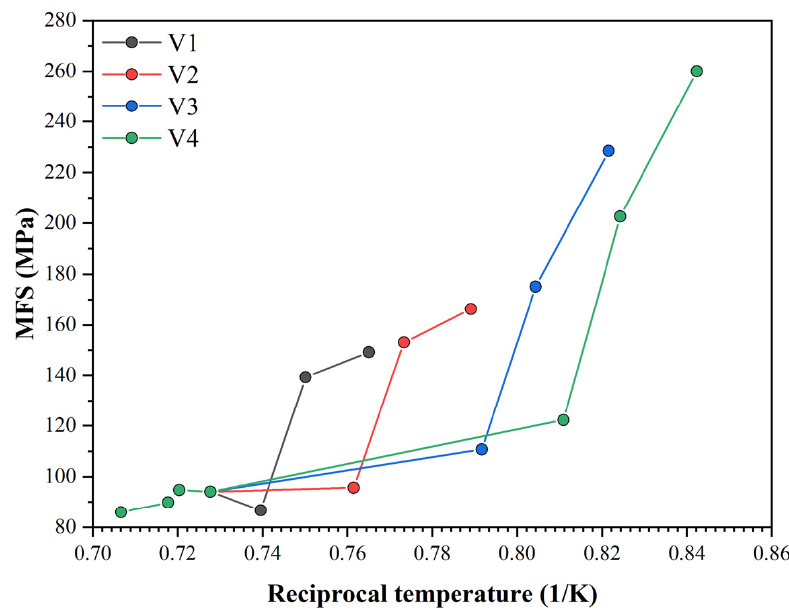
Figure 22. MFS dependencies on reciprocal temperature for each simulation variant.